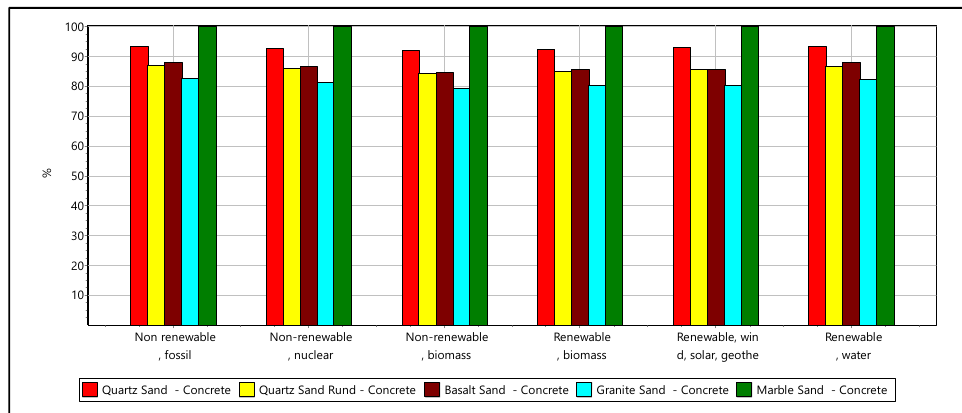
Figure 9. Energy demand analysis of primary raw material concrete samples within the life cycle of the concrete mixes.